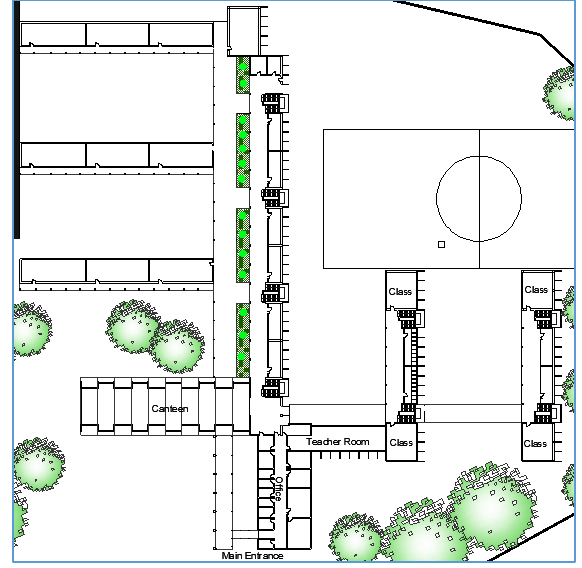
Figure 7. The Ground Floor Plan for Lefkoşa türk lisesi (Drawn by Author).